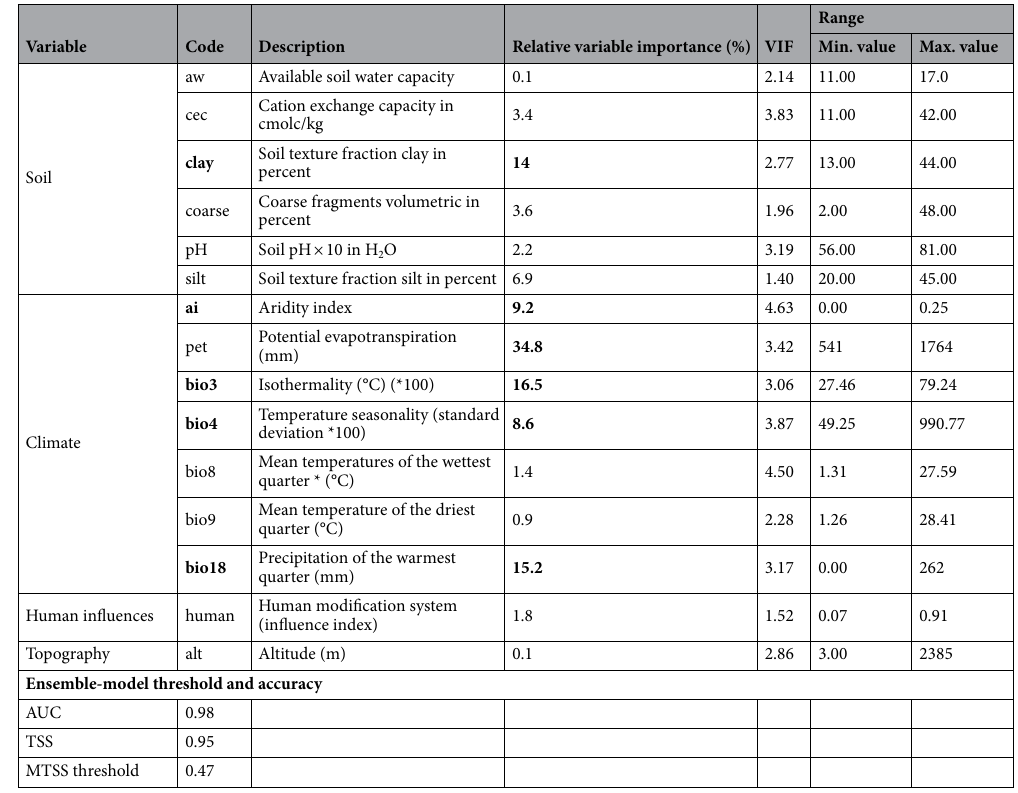
Table 1. Relative importance and range of predictor variables explaining potential distribution. The most important variables and their values are shown in bold. VIF, variance inflation factor; TSS, true skill statistic; AUC, area under the curve indicate the accuracy of the ensemble models; MTSS, maximum training sensitivity plus specificity threshold. *The term quarter means the mean temperatures during the wettest three months of the